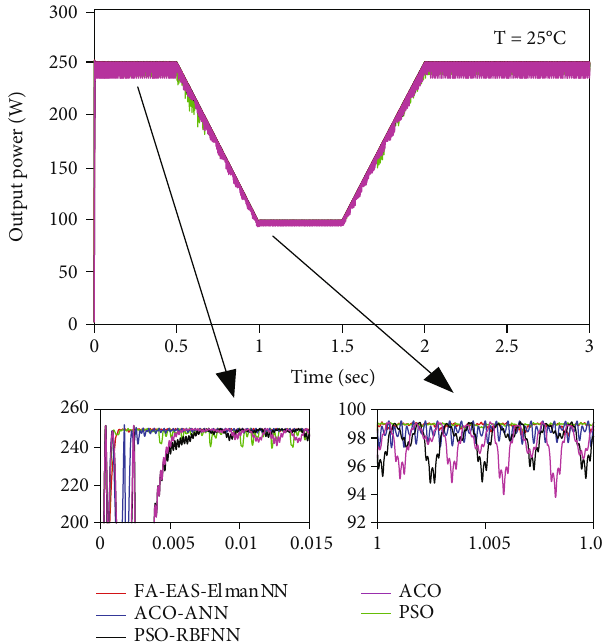
Figure 15: Output power of PV array under slowly changing G ( T = 25 °